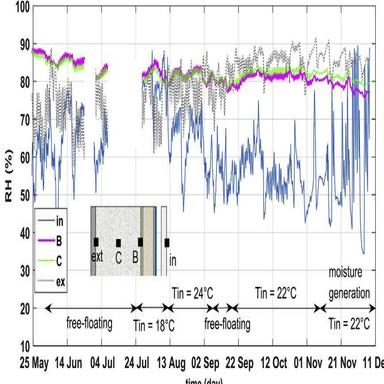
The relative humidity at the cross section of the wall for test cell 2 (internally insulated).